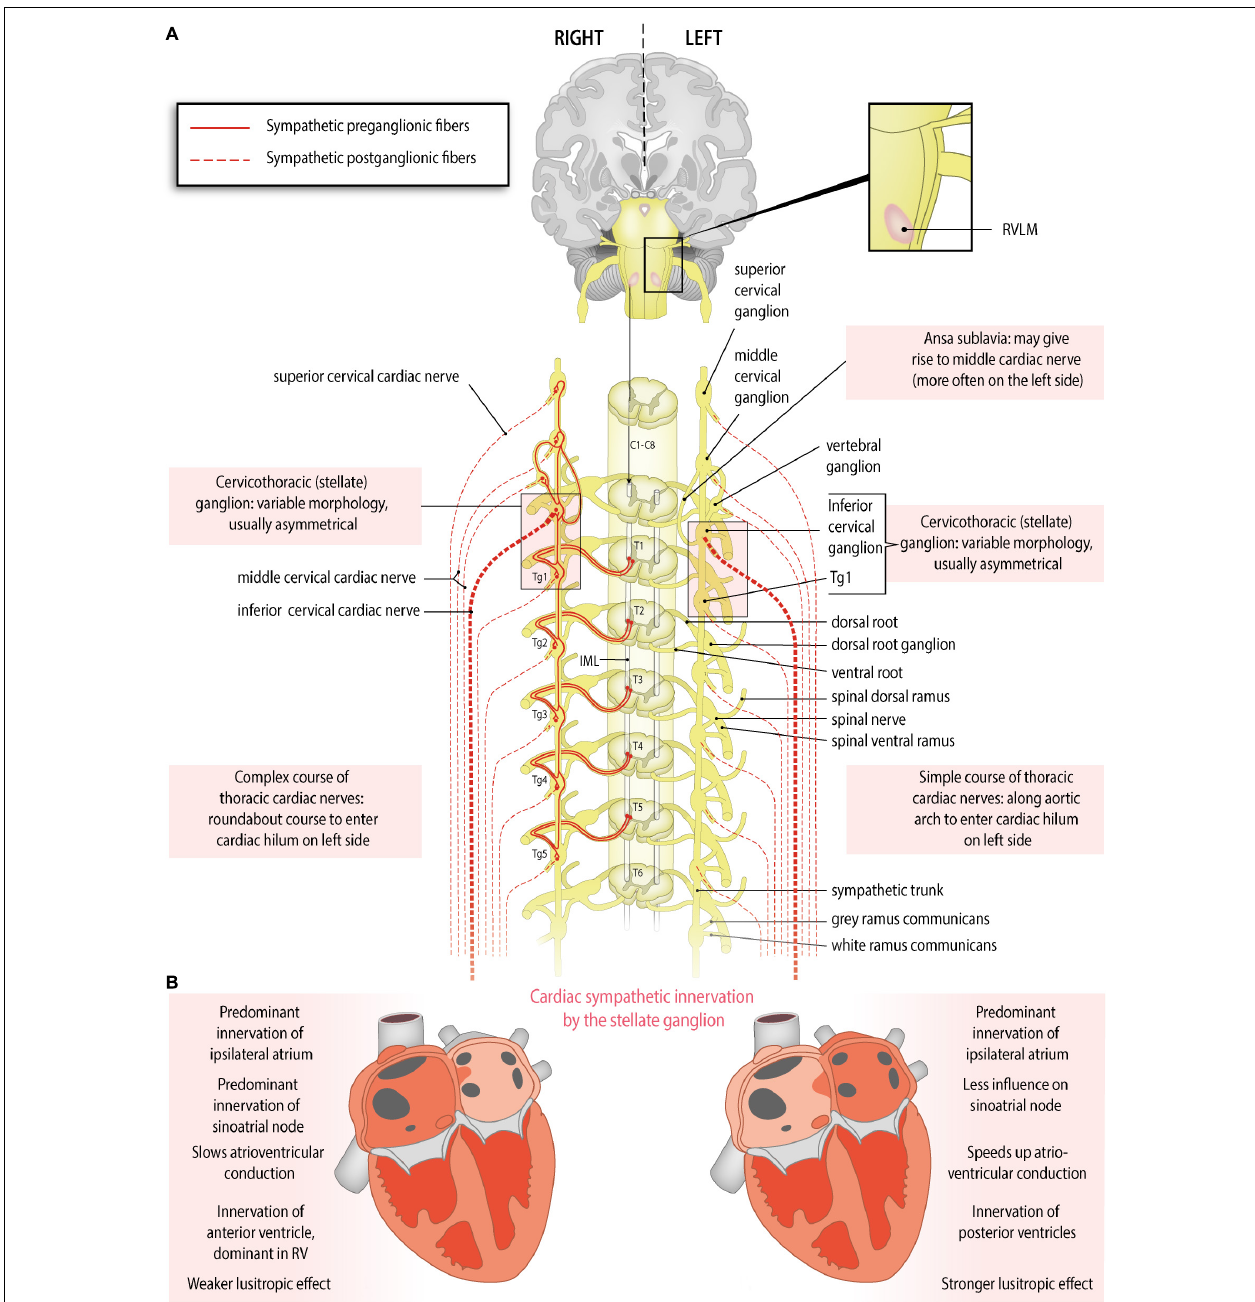
FIGURE 1 | Anatomy of the sympathetic cardiac autonomic nervous system: asymmetry and regional differences. (A) Sympathetic cardiac autonomic nervous system. Preganglionic cardiac sympathetic axons (red, solid lines) arise from neurons of the intermediolateral (IML) cell columns in the upper four or five thoracic segments of the spinal cord. These neurons receive excitatory input from the rostral ventrolateral medulla (RVLM). The preganglionic fibers leave the spinal cord through ventral (anterior) roots, enter the ventral (anterior) rami of spinal nerves and pass to the sympathetic chain through white rami communicantes to synapse in the upper thoracic ganglia (Tg) or cervical ganglia; postganglionic fibers (red, dotted lines) from these ganglia form the sympathetic cardiac nerves. At the heart parasympathetic and sympathetic nerves converge to form the cardiac plexus from which atrial and ventricular autonomic innervation is arranged. Sided and regional differences in anatomy are indicated in the boxes. (B) Functional anatomy of cardiac sympathetic innervation by the right and left stellate ganglia. Sided and regional differences in function are indicated in the boxes. The right stellate ganglion greatly increases heart rate, slows the atrioventricular conduction, influences the right atrium more strongly than the left, shortens the QT interval, contributes to some extent to myocardial relaxation, and is the predominant source of sympathetic innervation in the right ventricle and the anterior part of both ventricles. The left stellate ganglion increases heart rate to some extent, speeds up the atrioventricular conduction, influences the left atrium more strongly than the right, lengthens the QT interval, contributes greatly to myocardial relaxation, and is the predominant source of sympathetic innervation of the posterior part of the ventricles.